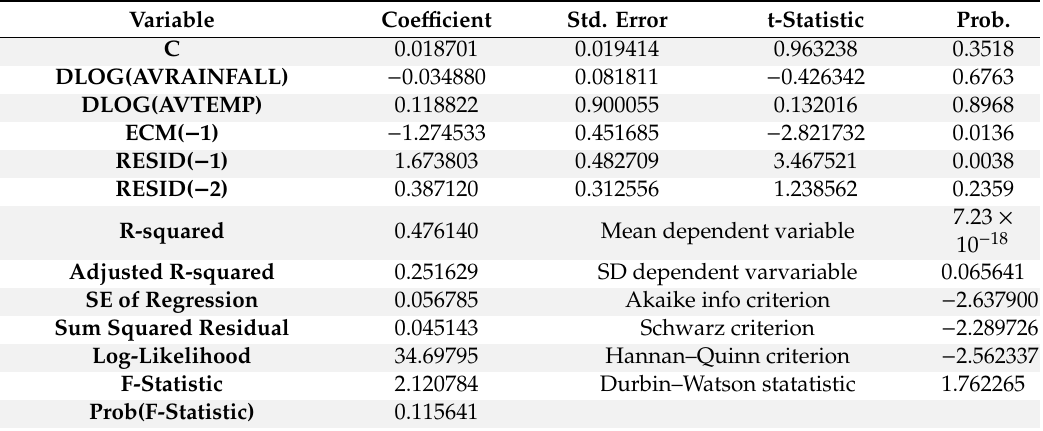
Table 6. Post regression test